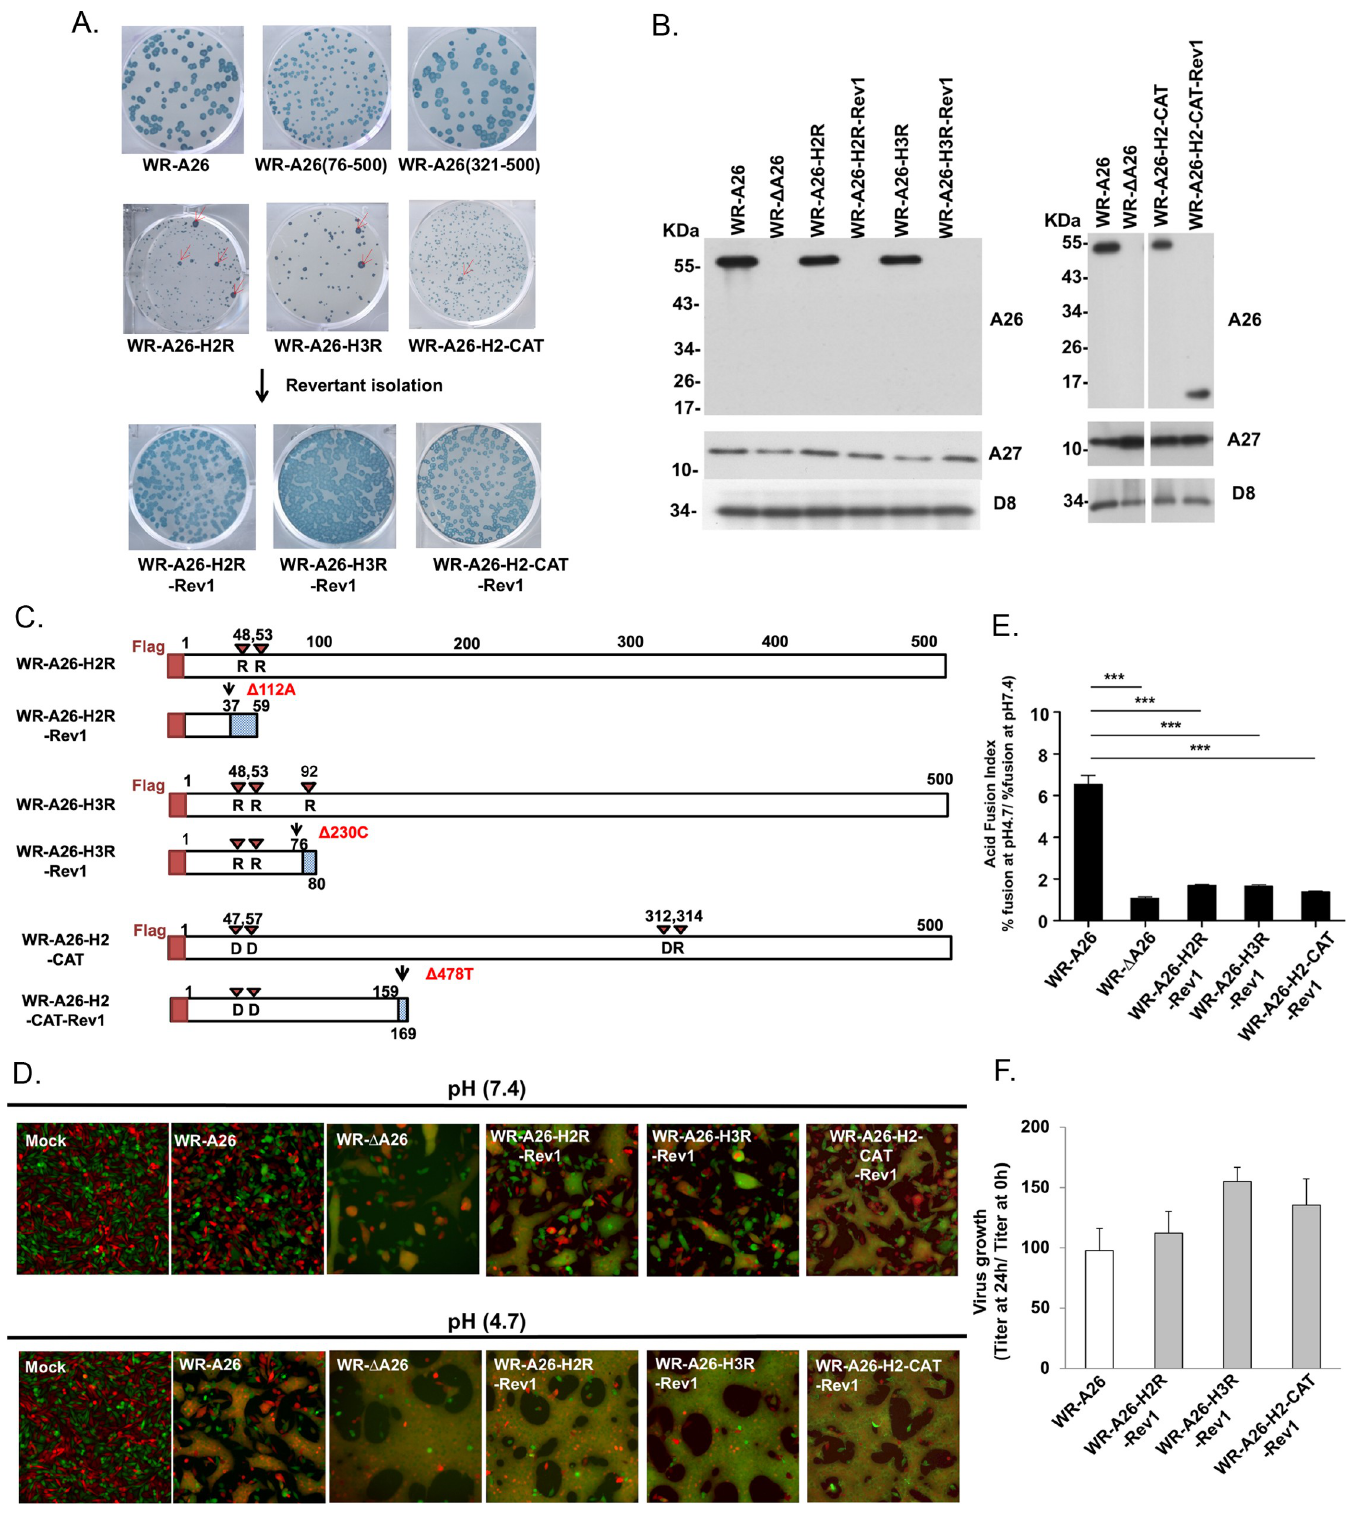
Fig 7. Revertant viruses exhibit a large plaque phenotype and regained MV infectivity by generating intragenic second-site mutations in the A26L ORF that caused a frame-shift and premature termination of A26 protein translation. (A). Plaque phenotypes of control WR-A26 virus and the small plaque phenotype of various A26 mutant viruses. Low percentages (~2%) of large plaque revertants (Rev) (indicated by red arrows) were isolated from each mutant virus and plaque-purified. (B).